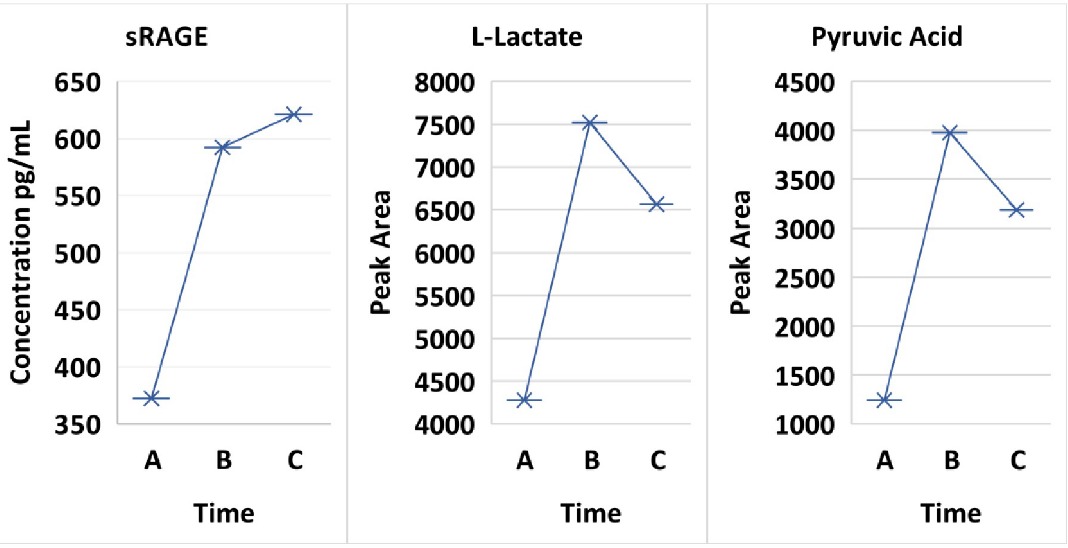
Fig 9. Comparison of sRAGE to L-lactate and pyruvic